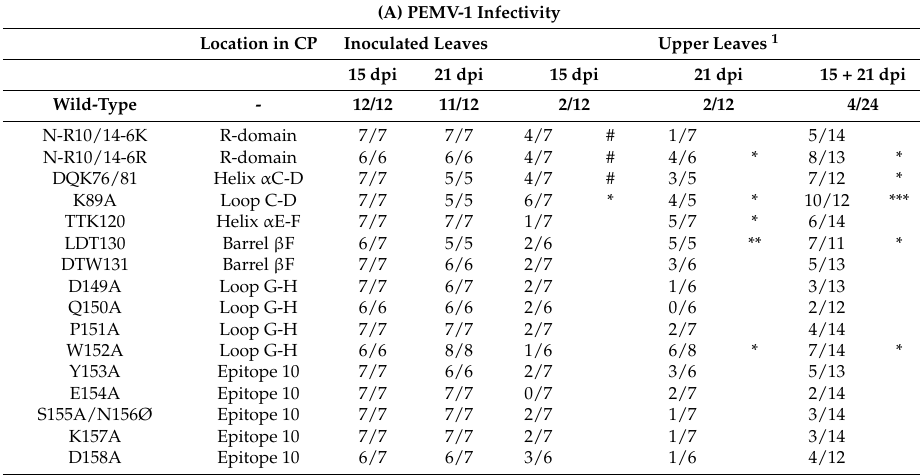
Table 1. Infectivity of wild-type (WT) and mutant Pea enation mosaic virus (PEMV). PEMV 1 ( A ) or PEMV2 ( B ) was detected using real time PCR for wild-type and mutant viruses at 15 and 21 days post-inoculation (dpi). The number of positives over the total number of plants tested is shown. While virus was detected in almost all of the inoculated leaves, significant differences were noted for detection of virus in upper